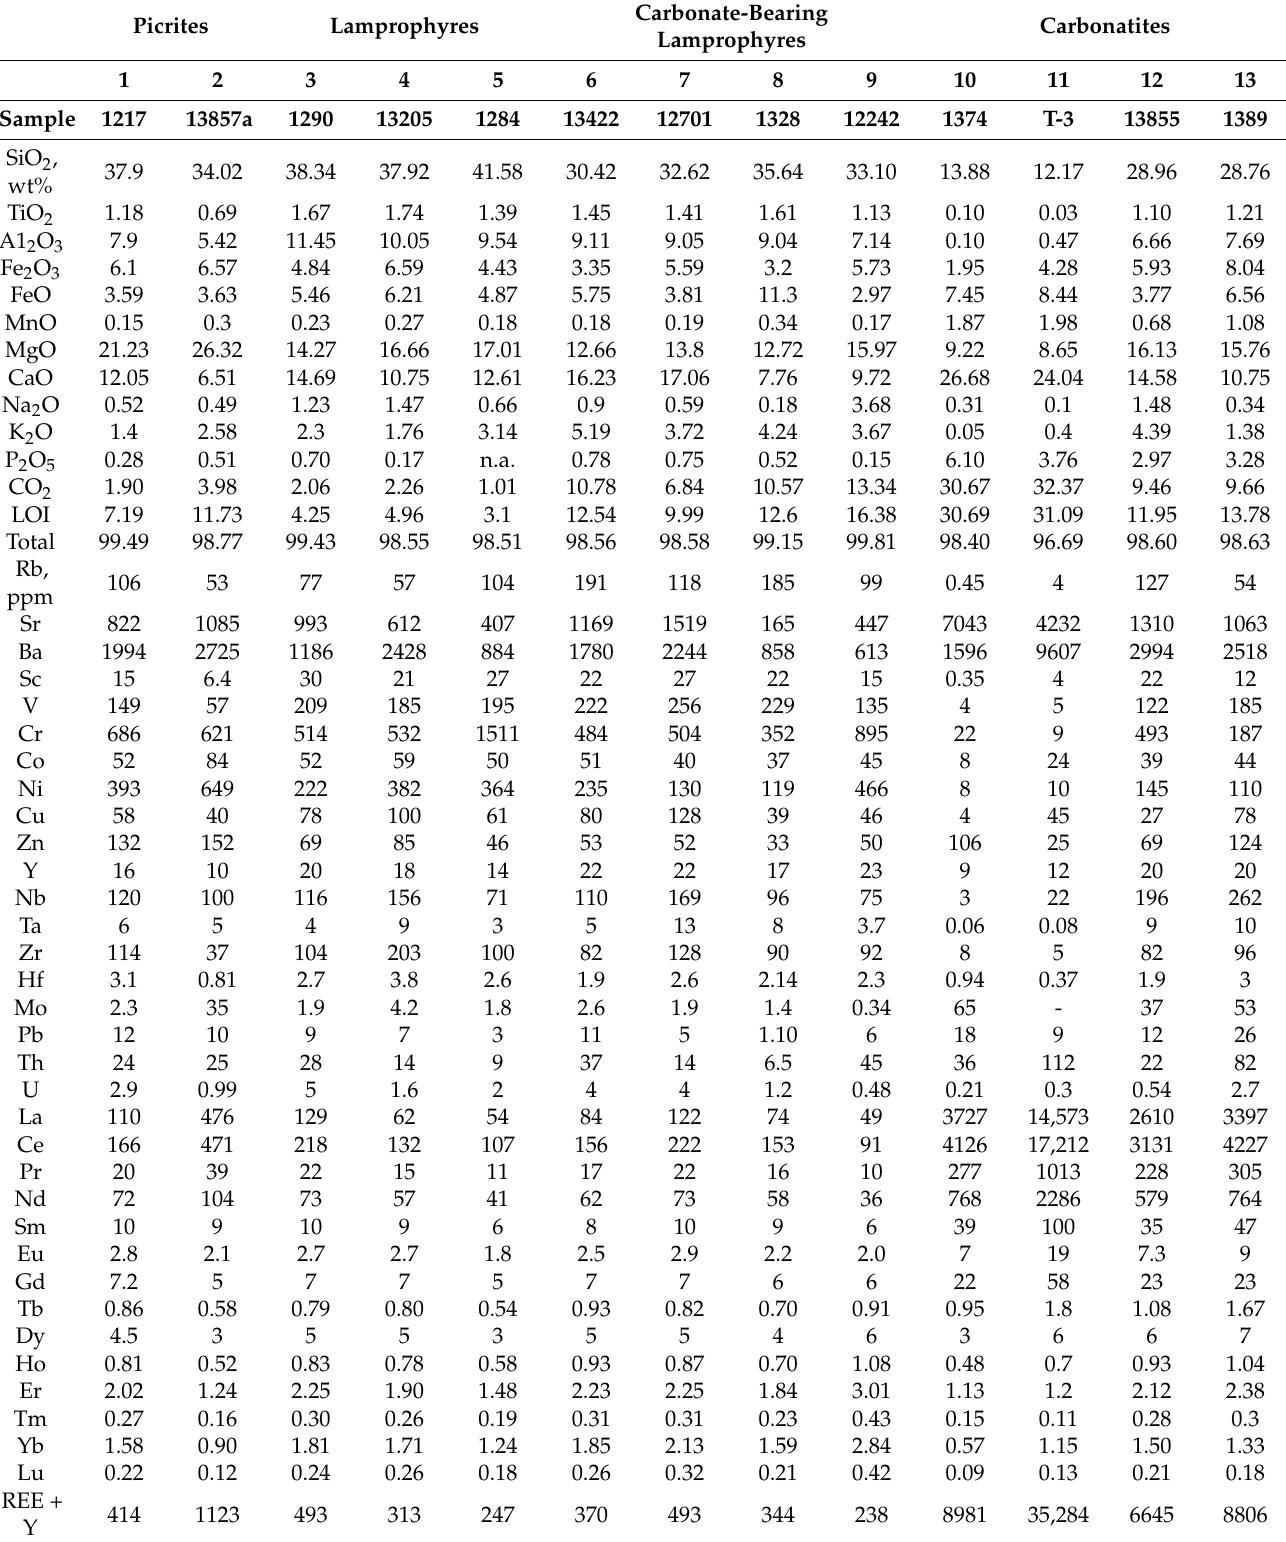
Table 4. Representative chemical composition of rocks from the Chetlassky carbonatite complex, Middle